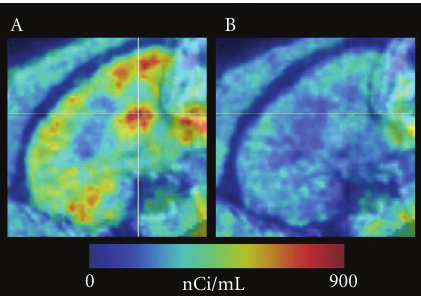
Figure 1: Averaged saggital baboon brain PET images of [11C]JHU75528 scans, displayed on aligned MRI images. Lines cross at the center of left putamen. The images are shown in the same color scale. (A) baseline; (B) blocking with Rimonabant (1mg/kg, i.v.). Images display the putamen, frontal, parietal, and occipital cortices, and cerebellum, among other structures. In the baseline scan, the radioactivity accumulated predominantly to the putamen, frontal cortex, and cerebellum, and less to thalamus and